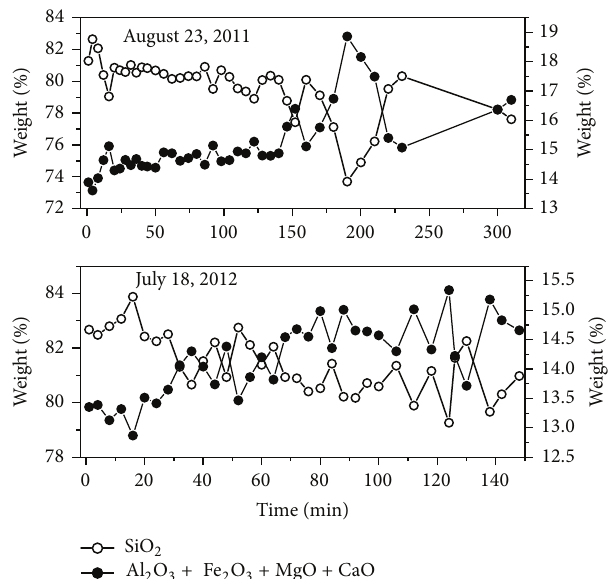
Figure 6: Temporal changes in elements Si and Al+Fe+Mg+Ca during the two flood events.